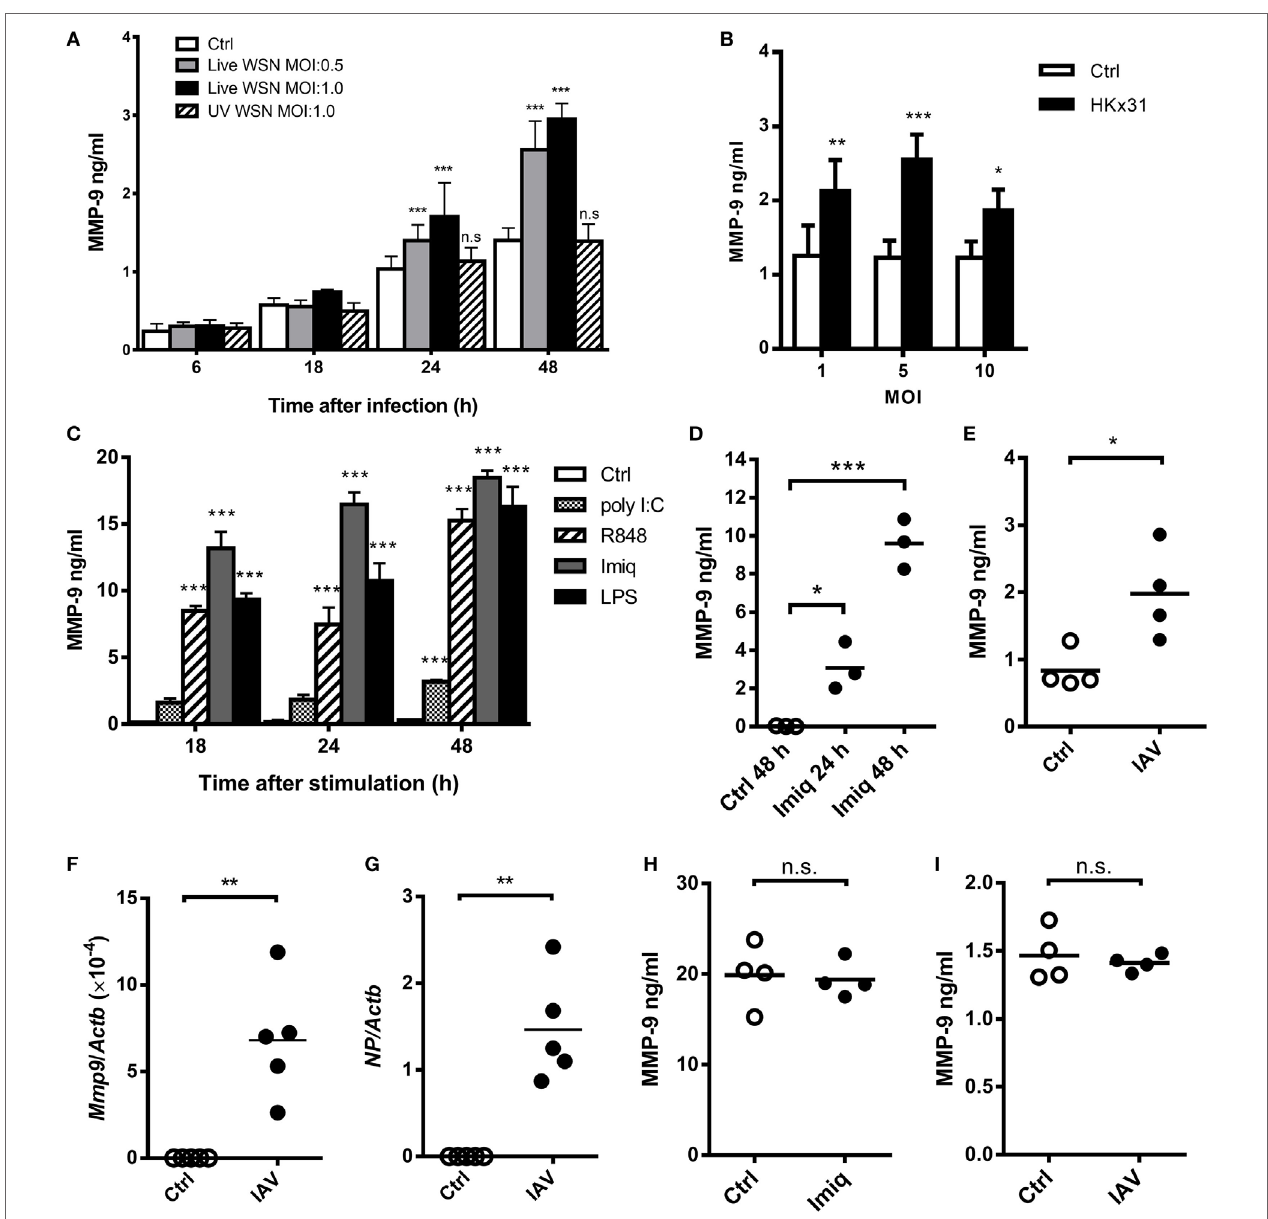
FigUre 1 | Influenza A virus (IAV) and toll-like receptor 7 agonists induce alveolar macrophage matrix metalloproteinase-9 (MMP-9) production. (a) MH-S cells were stimulated with or without live or UV-inactivated WSN strain of IAV at different MOIs for indicated periods of time ( n = 4, four independent experiments). (B) MH-S cells were stimulated with or without HKx31 virus at different MOIs for 48 h before harvest ( n = 4, four independent experiments). (c) MH-S cells were stimulated with or without poly I:C (50 µg/ml), R848 (10 µM), imiquimod (Imiq, 1 µg/ml), or LPS (1 µg/ml) for indicated periods of time ( n = 3, three independent experiments). (D) Primary alveolar macrophages of wild-type mice stimulated with or without Imiq (1 µg/ml) for indicated periods of time. (e) Thioglycollate-elicited peritoneal macrophages stimulated with or without HKx31 virus (MOI = 10) for 48 h. (F,g) Wild-type mice were infected with 5 × 10 3 PFU of WSN virus intratracheally for 2 days. Alveolar macrophages (Siglec-F + F4/80 + ) in bronchoalveolar lavage were sorted and Mmp9 and viral nucleoprotein mRNA were quantified by qPCR and normalized against Actb . Primary neutrophils from bone marrow were stimulated with or without (h) Imiq (1 µg/ml) and (i) WSN virus (MOI = 1) for 24 h. (D–i) Each dot represents cells from one mouse. (a–e,h,i) MMP-9 in culture supernatants was quantified by ELISA. Data presented are the mean + SD. * p < 0.05, ** p < 0.01, and *** p < 0.001 when compared to unstimulated cells. (a–D) was analyzed by one-way ANOVA, followed by (a) Turkey’s, (B) Sidak’s, (c,D) Dunnett’s post hoc tests, and (e–i) by Mann–Whitney U